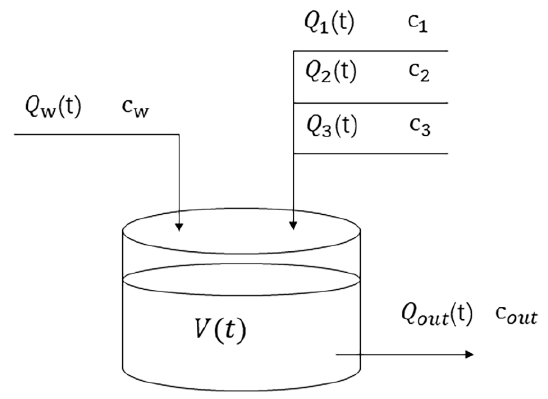
4 of 19 Figure 1. Water and fertilizer integration and control equipment structure diagram: 1—check valve; 2—flow meter; 3—computer control; 4—water source; 5—solenoid valve; 6—acid tanks; 7—hose